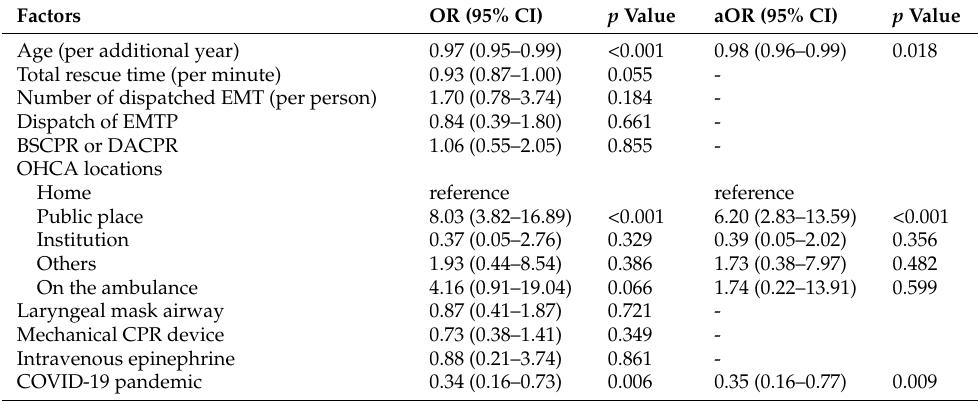
Table 5. Predictive factors of accomplishing discharge with favorable neurologic